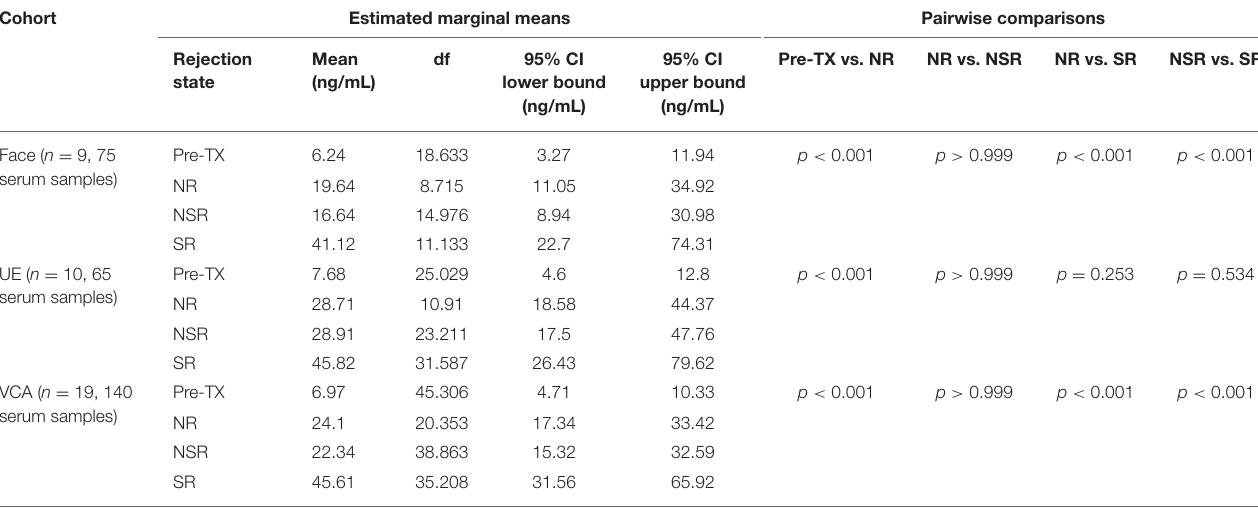
TABLE 2 | Effects of rejection state on MMP3 levels in linear mixed model.